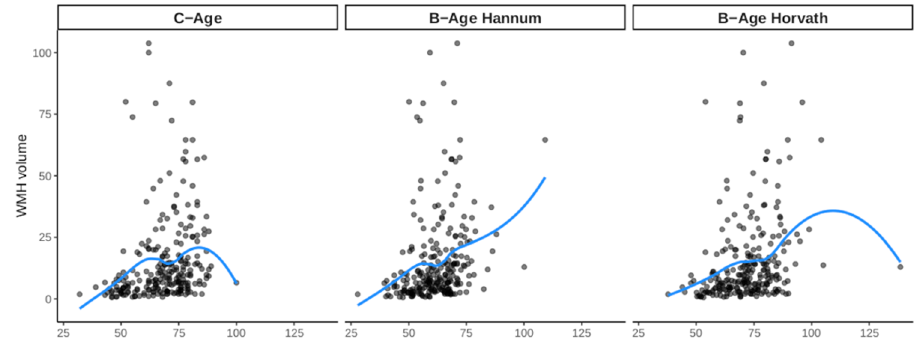
Figure 2. Bivariate association between chronological and biological age estimations and WMH volume. The blue line represents the “loess” fit in each case.